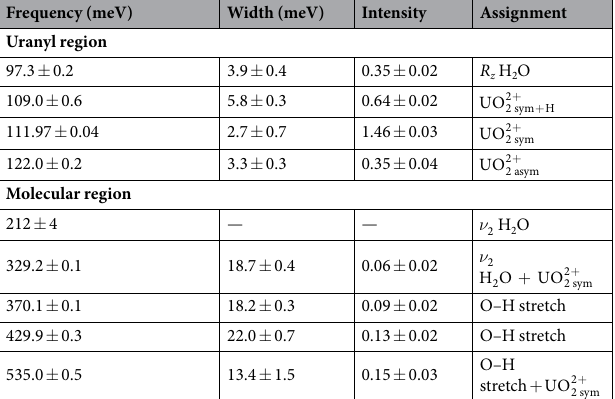
Frequency (meV) Width (meV) Intensity Assignment